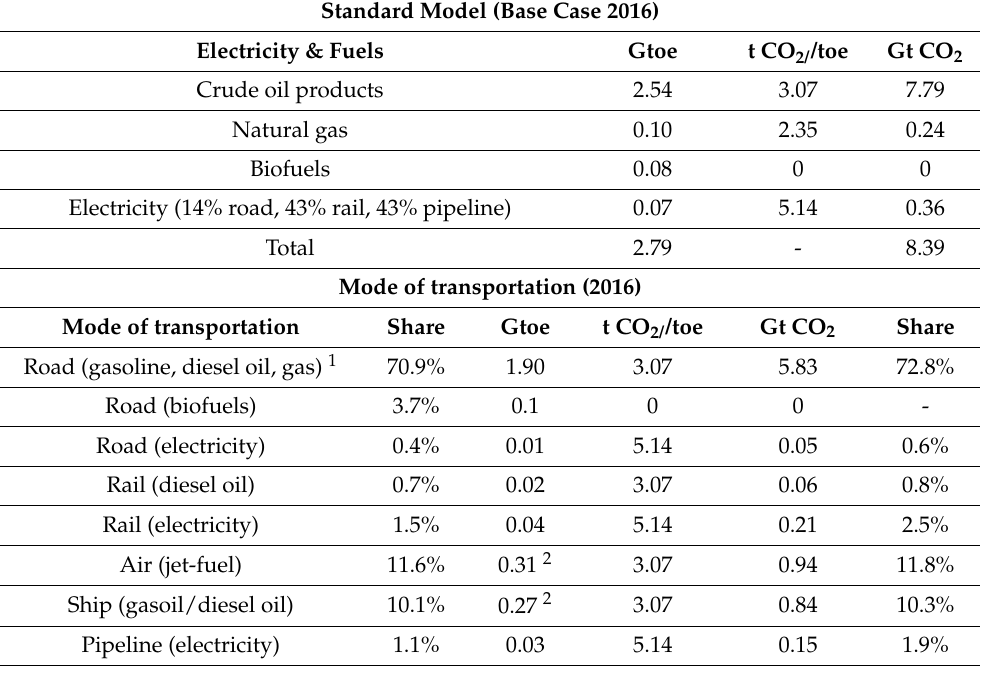
Table 3. Global transport 2016 (data from